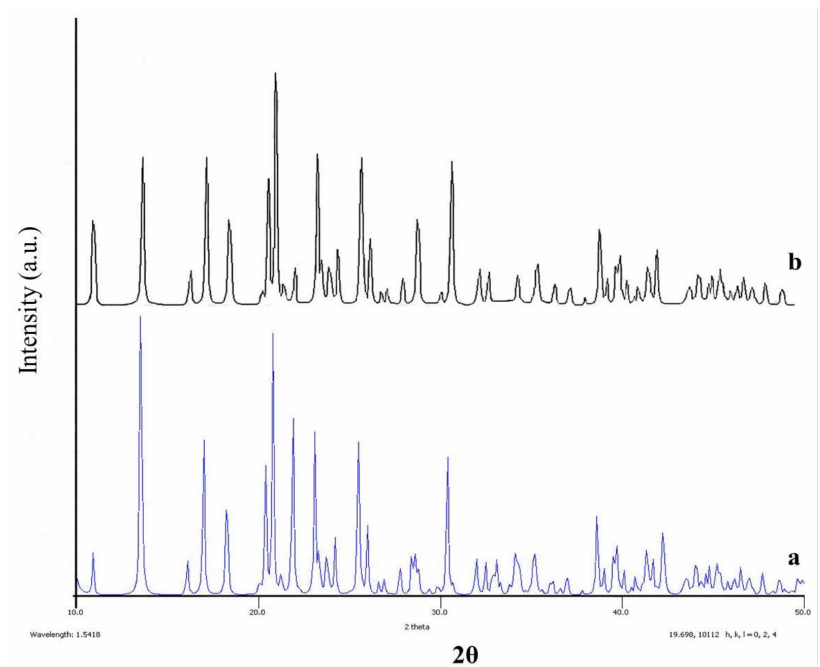
Figure 2. SEM images of the [Cd(L)(NO 2 ) 2 ] n .